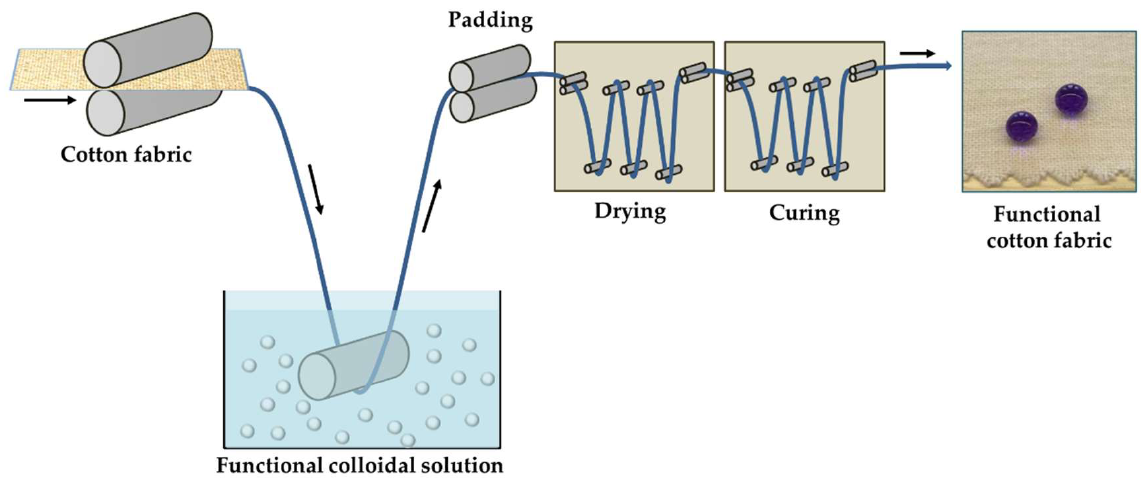
Figure 3. Pad-dry-cure process employed for finishing cotton fabrics.